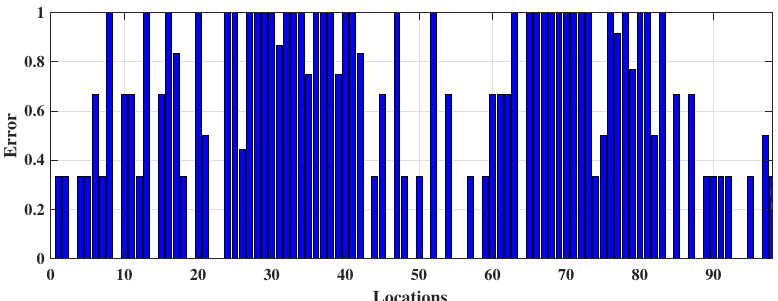
Figure 11. The occurrence of error in each coordinate from 1 NN Ja classification during online phase.